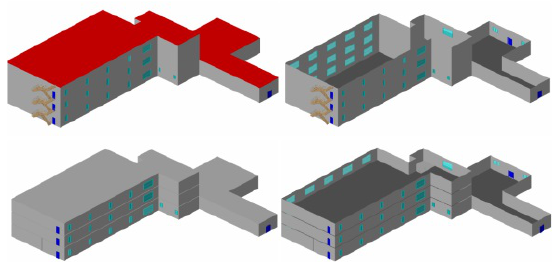
Figure 5: CityGML LoD 3(Top) & CityGML LoD 4 (Bottom) models of Building 1